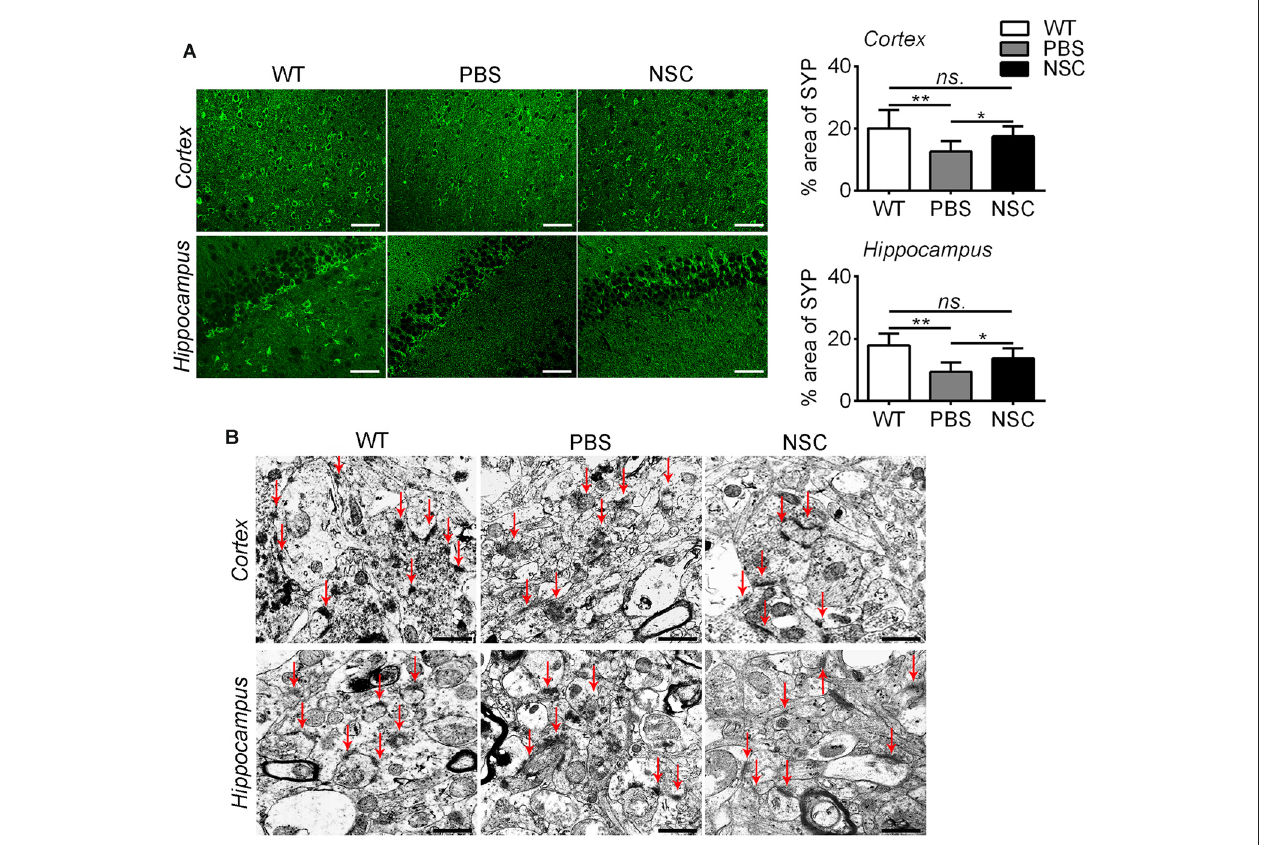
FIGURE 5 | hNSCs rescued synapses in APP/PS1 mice brains. (A) SYP-staining sections in the brains of PBS, NSC group and WT mice, and quantification of SYP-staining in the frontal cortex and hippocampus of three groups of mice. There was no significant difference in % area of SYP between the NSC group and WT mice ( ns. = p > 0.05), ∗ p < 0.05; ∗∗ p < 0.01 vs. the PBS group. Scale bar: 20 µ m. (B) Ultrastructure analysis showed that synapses (red arrow) were dense and intact in the cortex and hippocampus of WT mice, appeared structurally loose and sparsely distributed in PBS group mice, but regained well-structured shapes and densely spaced in NSC group mice. Arrow indicates synapses. Scale bar: 1 µ